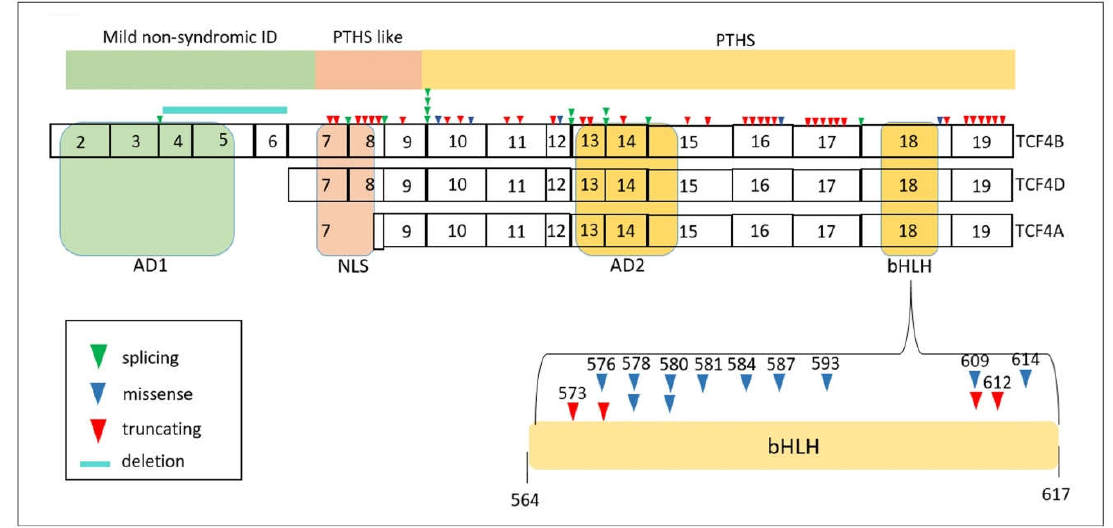
Figure 6. Structure of TCF4 and locations of pathogenic mutations registered in ClinVar. AD1, first activation domain; AD2, second activation domain (AD1 and AD2 modulate transcriptional activity); NLS, nuclear localization signal (controls subcellular localization); bHLH, basic helix-loop-helix.